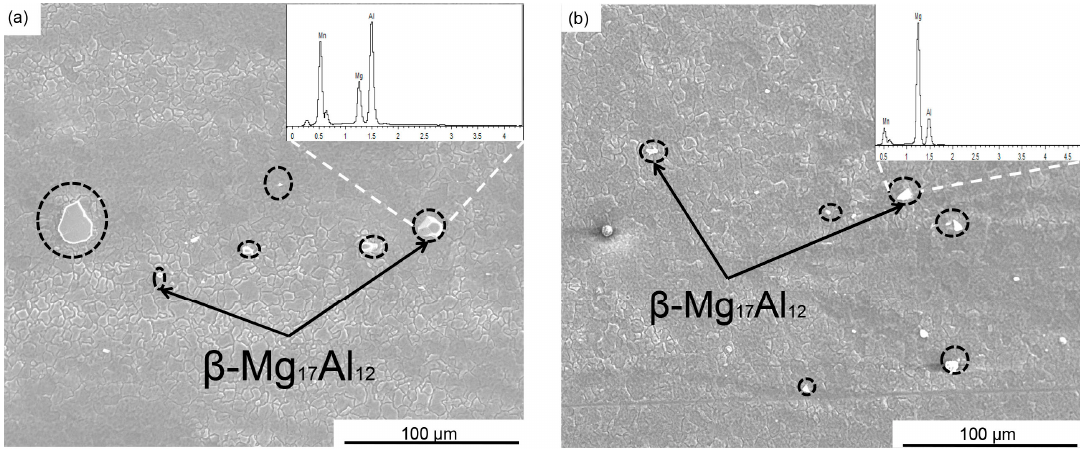
Figure 4. SEM micrographs in SZ of AZ61 Mg alloy samples: ( a ) one-pass SFSP and ( b ) two-pass SFSP specimens.